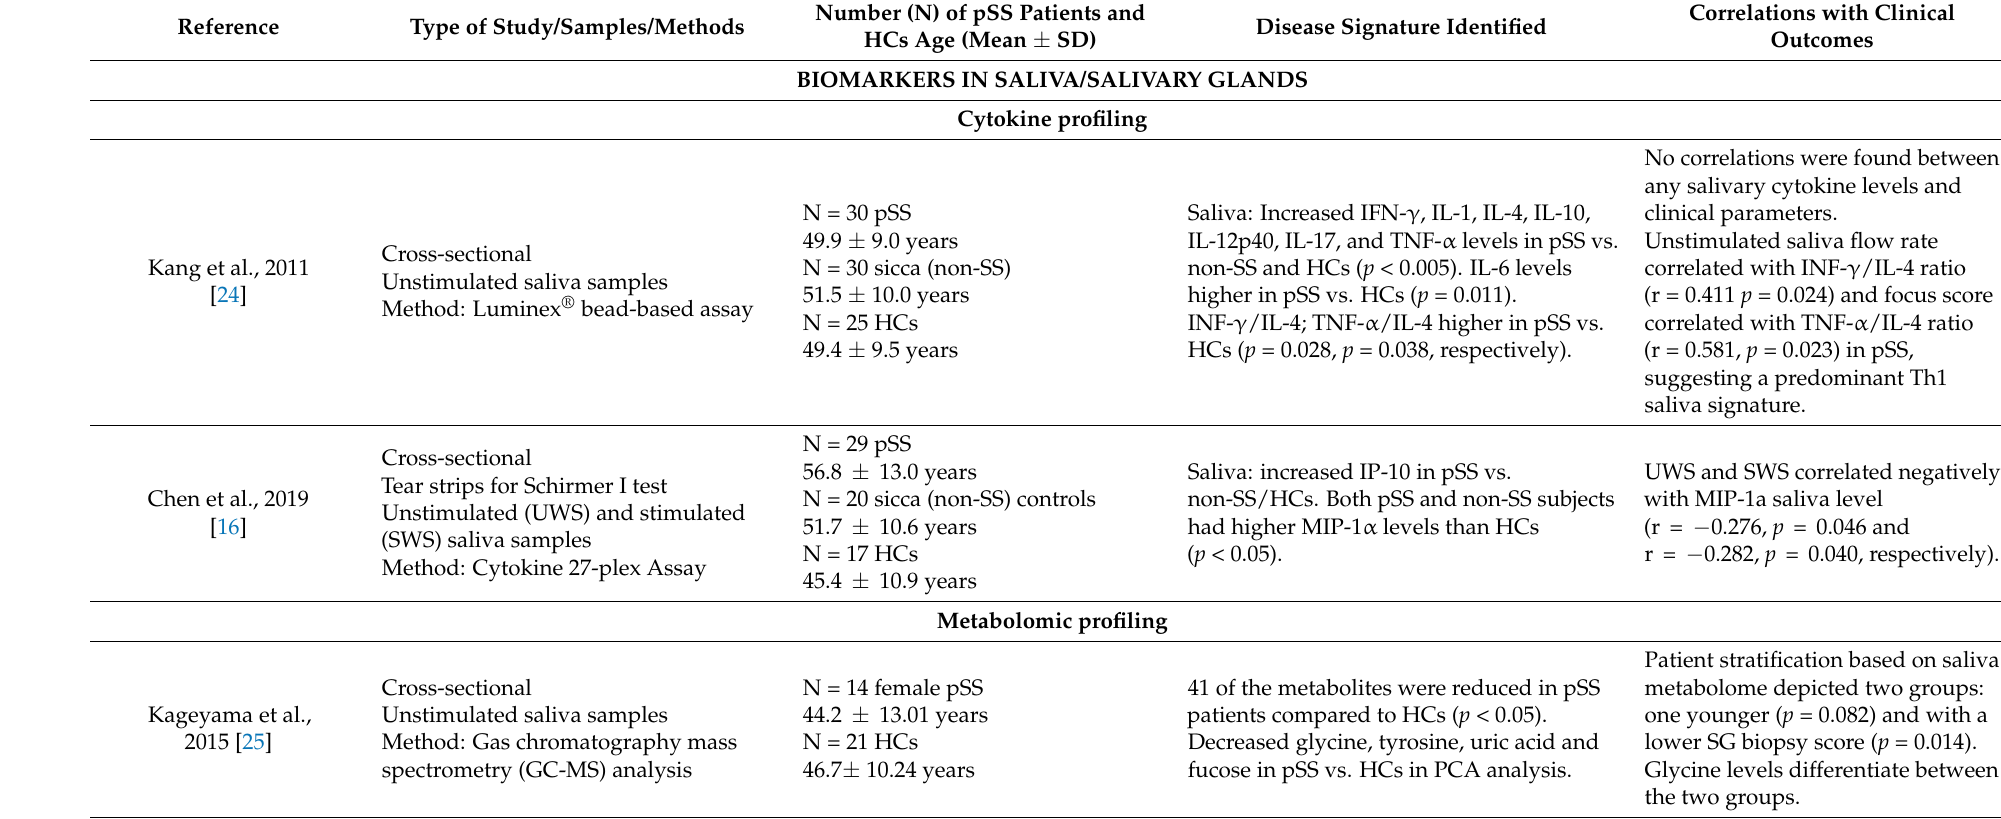
Table 2. Examples of studies investigating potential Sjögren’s Syndrome biomarkers in saliva/salivary